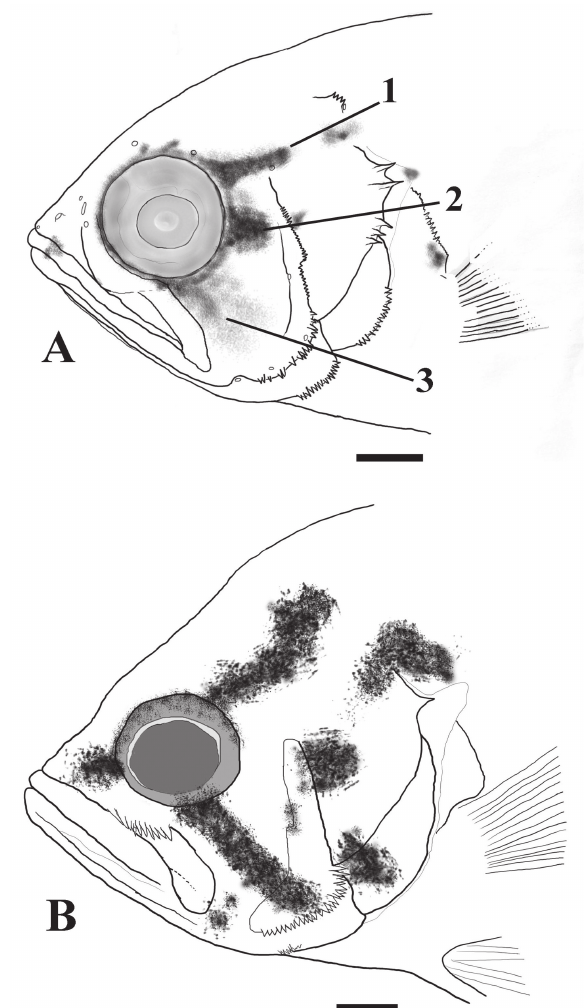
Fig. 2. Left lateral view of the head of (A) Polycentrus jundia , holotype, MZUSP 54586, 28.3 mm SL, and (B) Polycentrus schomburgkii MPEG 3294, 1, 40.7 mm SL; (1) upper postorbital diagonal band; (2) postorbital median horizontal band; (3) suborbital diagonal band. Scale bars = 2 mm.